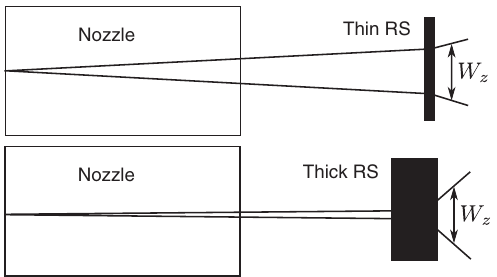
FIG. 12. As Fig. 10, but at the Bragg peak, in water. Lower curves show lateral penumbra for carbon ions.